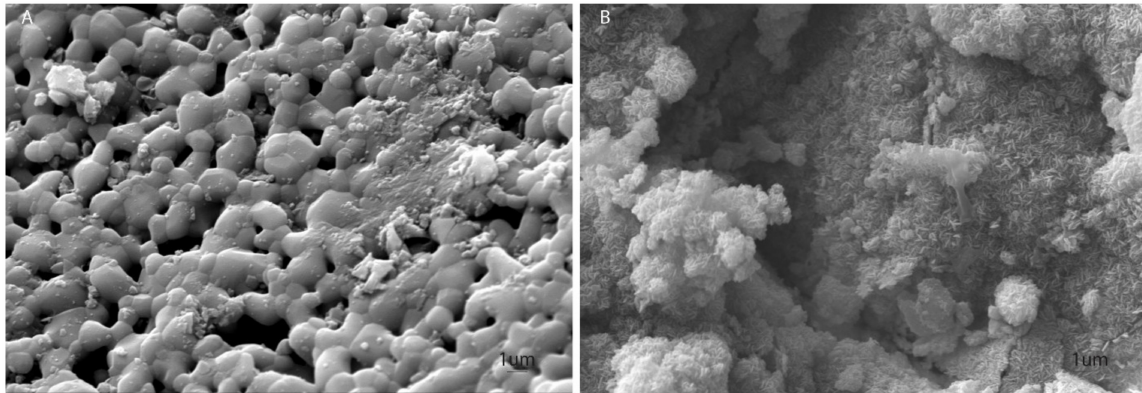
Figure 1. Scanning electron microscopy (SEM) analysis of S-HA and B-HA. ( A ) SEM S-HA images show its porous structure, Scale bar: 1 µ m, × 11,57 K. ( B ) B-HA structure is characterized by nano-metric particles forming thin lamellae with a microstructure composed of nano-size building blocks and multi-scale porosity, Scale bar: 1 µ m, × 10,210